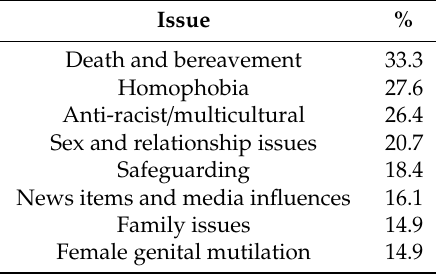
Table 2. Which three issues do you anticipate finding the most di ffi cult to address in